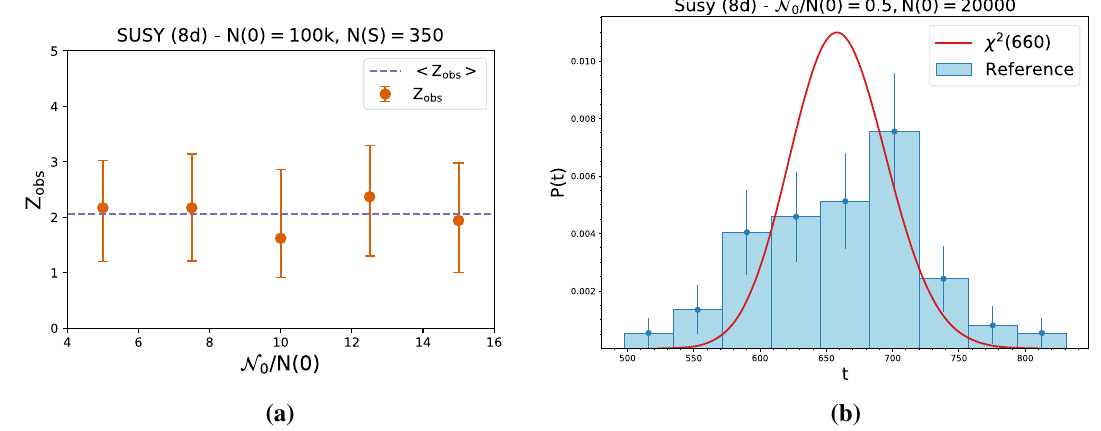
Fig. 7 Observed significance as a function of the size of the reference sample (left). Example of distribution of the test statistics given a small reference sample (right)